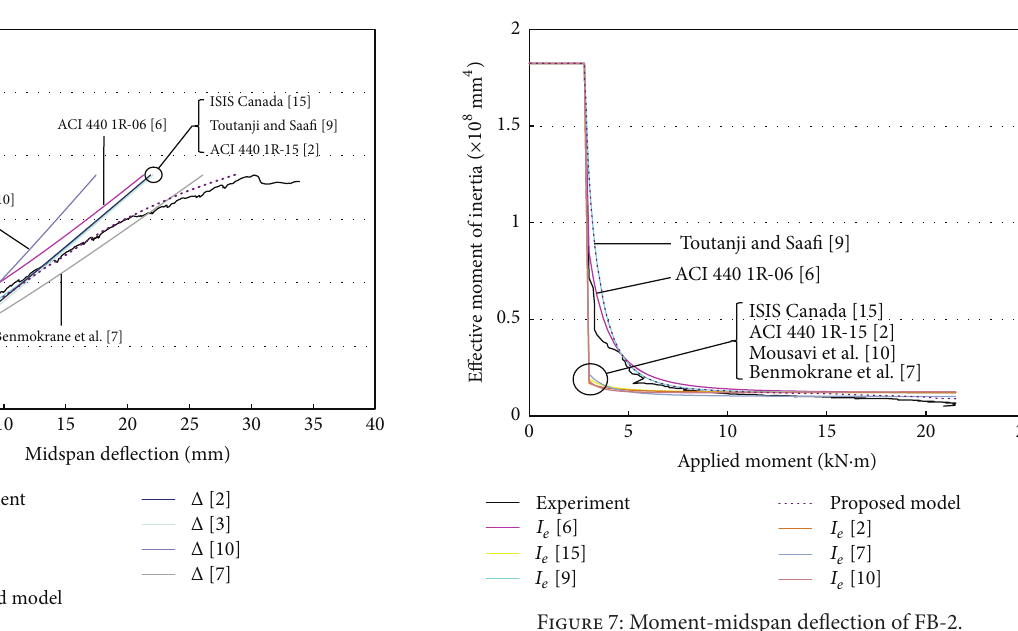
Figure 6: Moment-midspan deflection of FB-1.